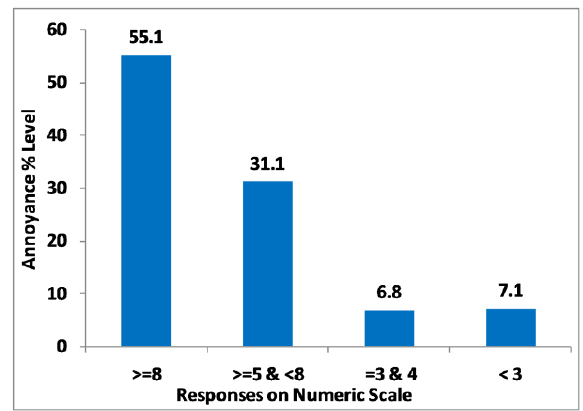
Figure 5. Noise annoyance percentage